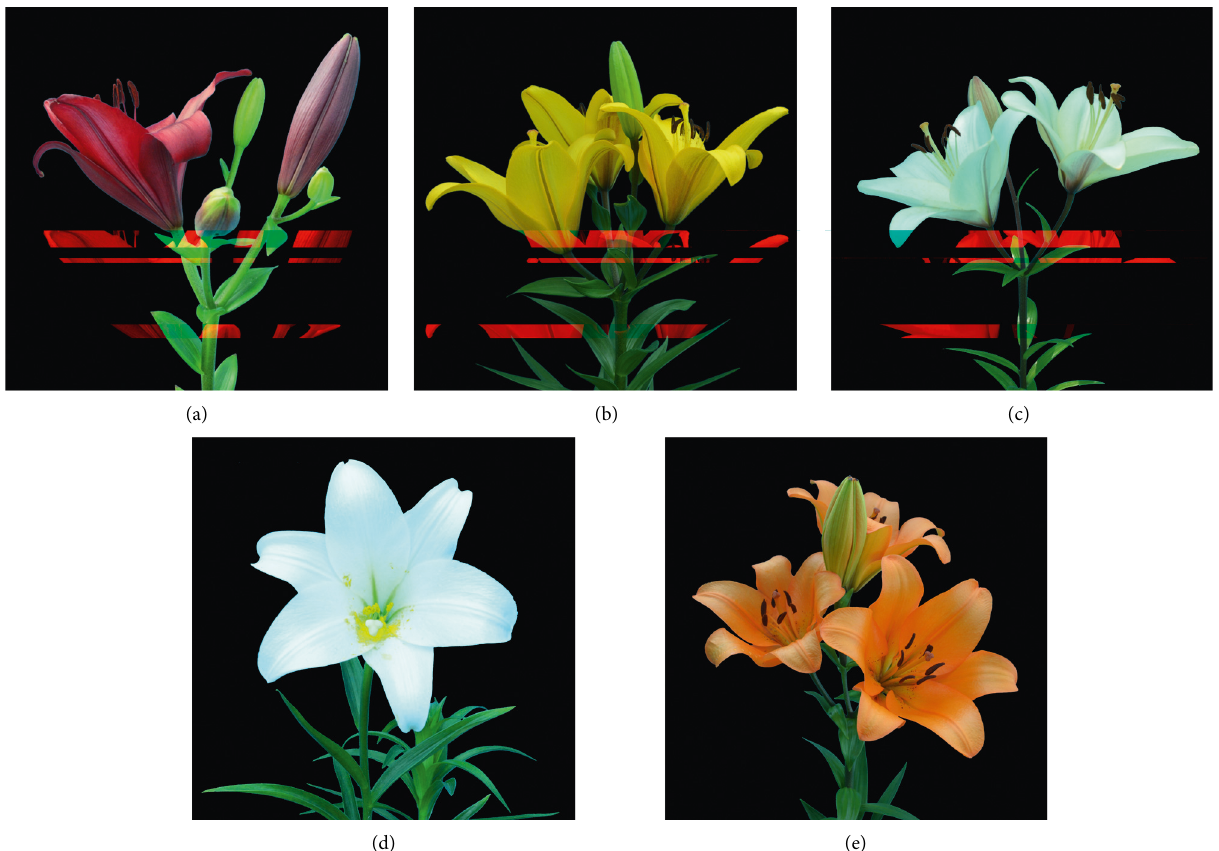
Figure 2: Lilies flowering on plants grown from microbulbs. (a) Lilium “Batavus.” (b) Lilium “Yellow Diamond.” (c) Lilium “Champion Diamond.” (d) Lilium sp. (e) Lilium “Hyde